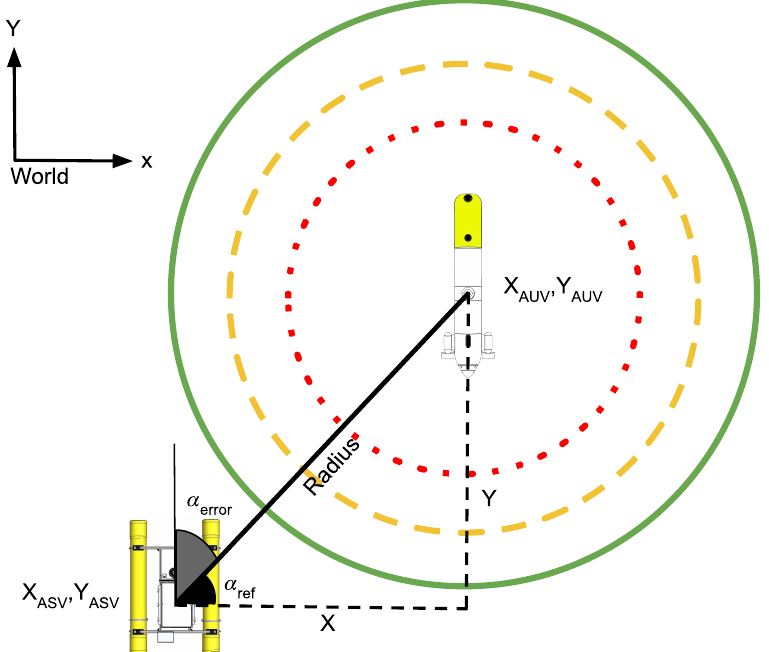
Figure 5. X AUV , Y AUV ,and X ASV , Y ASV represent the AUV and the ASV positions, respectively referenced to the world NED reference system. The red dotted circle represents the repulsion radius, the orange dashed circle represents the adrift radius, and the green circle represents the tracking radius.